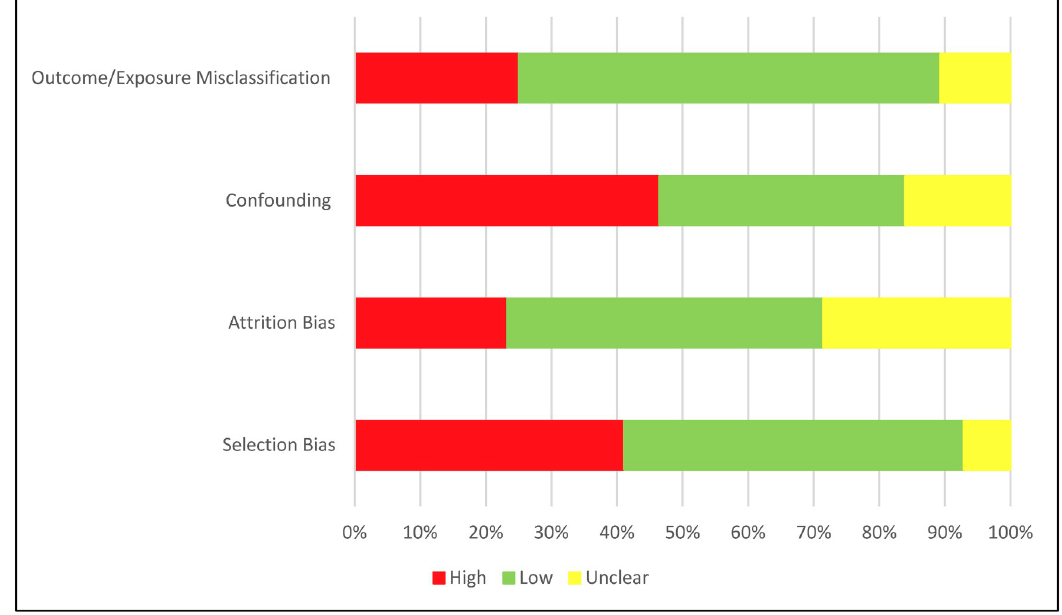
Fig 5. Risk of bias assessment for observational